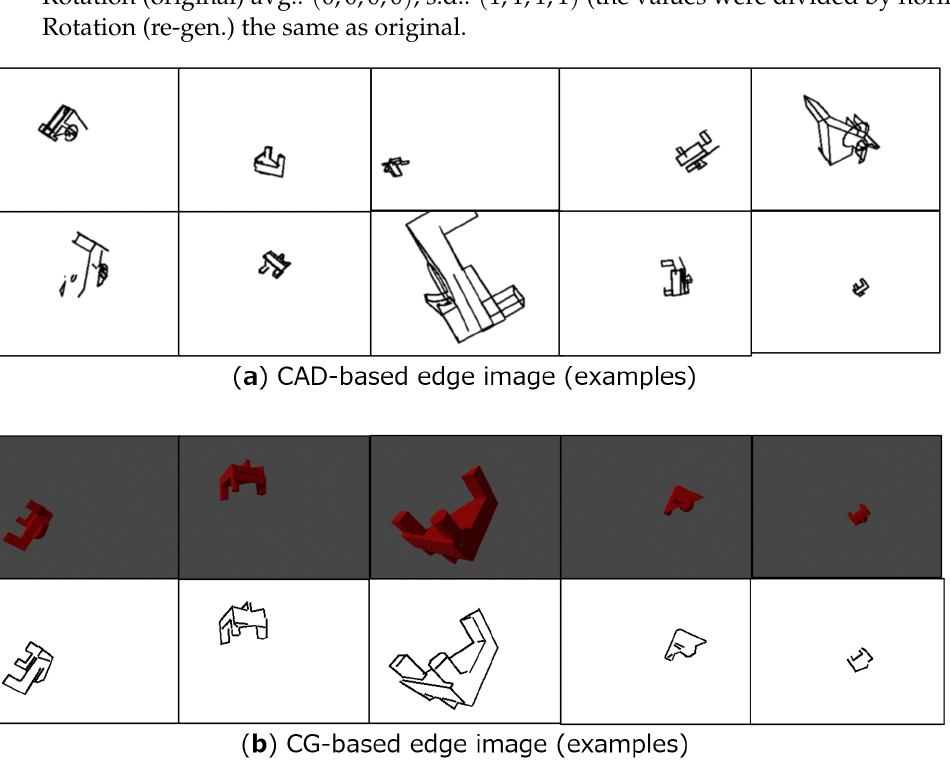
Figure 3. Examples of edge images created by simulation